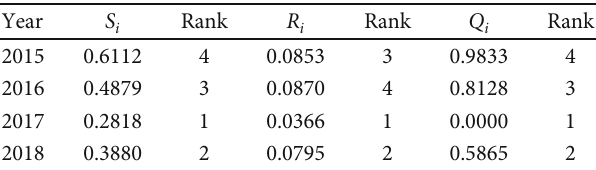
i value of water resource life cycle